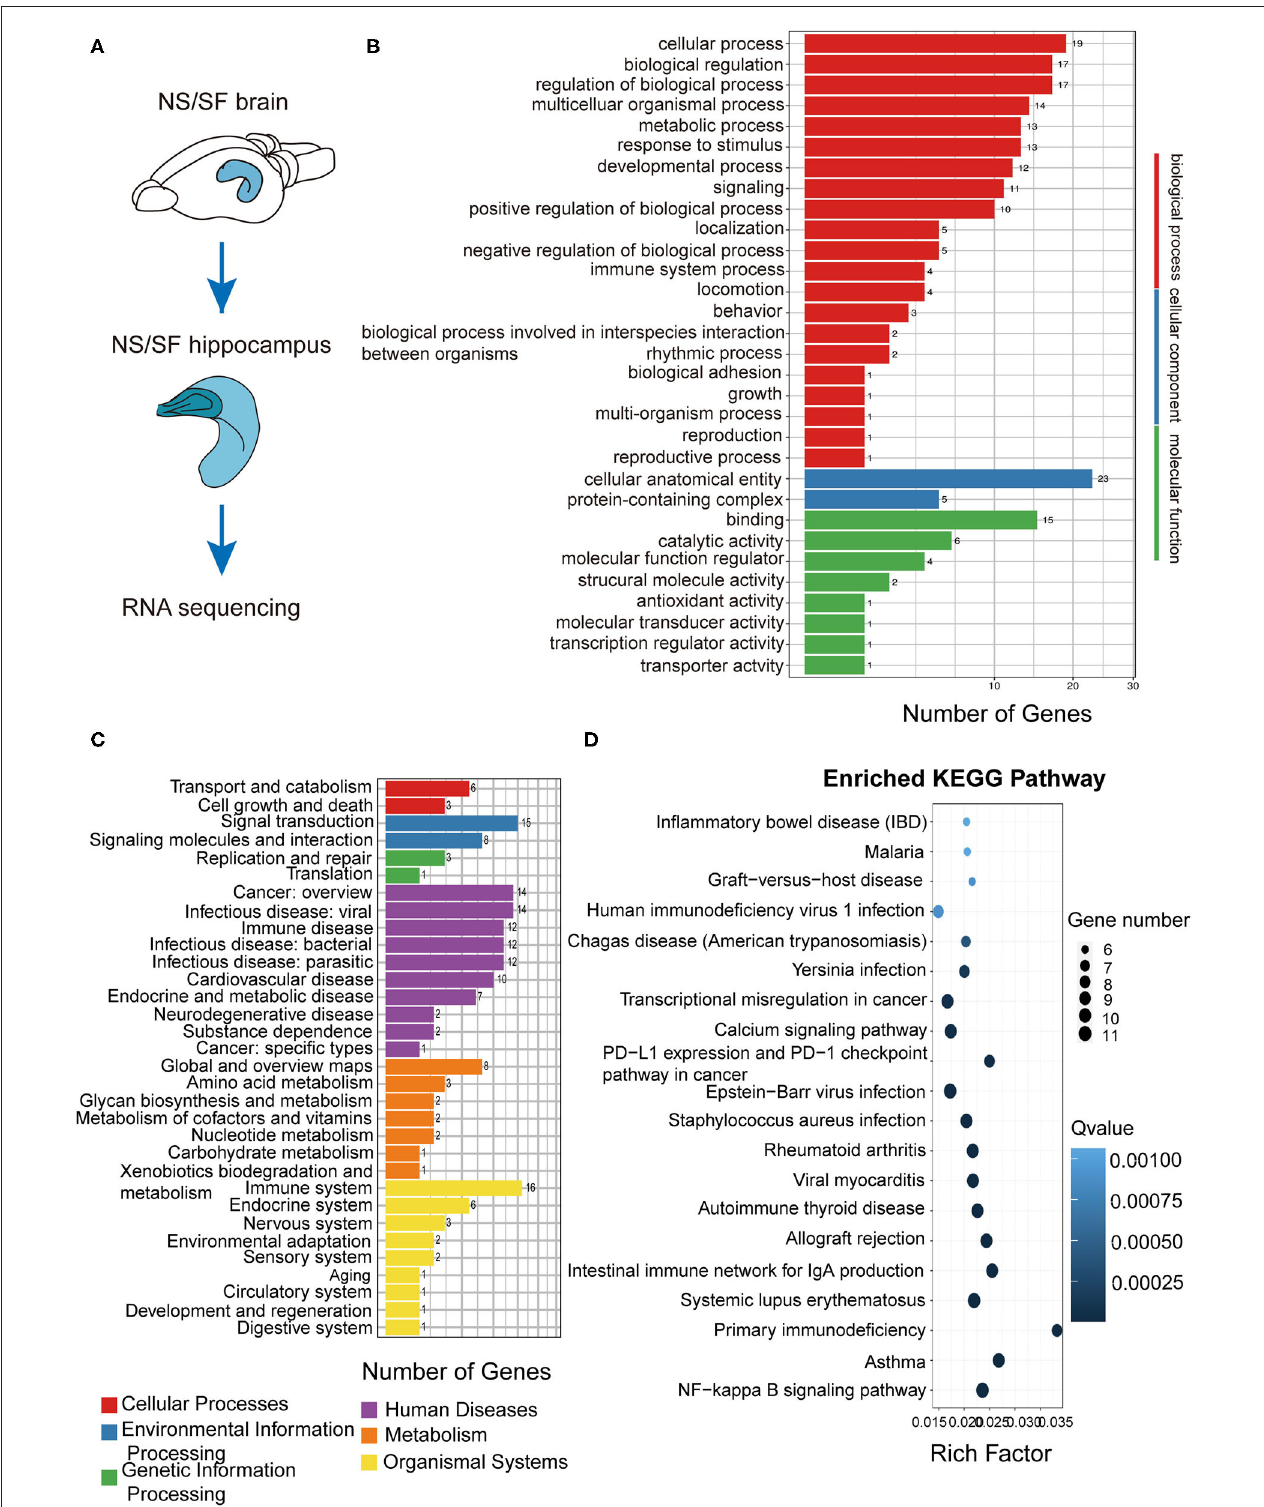
FIGURE 4 | Functional annotation of DEGs from the hippocampus in SF mice. (A) The schematic of hippocampus RNA sequencing. (B) The differential gene GO function classification map of the hippocampus. (C) KEGG classification on the DEGs from the SF hippocampus. (D) Statistics of KEGG pathway enrichment of DEGs map of SF hippocampus. The X-axis represents the enrichment factor, the Y-axis represents the pathway name, and color represents the Q value; the smaller the value, the more significant the enrichment result; the size of the point represents the number of DEGs. n = 3 per group.